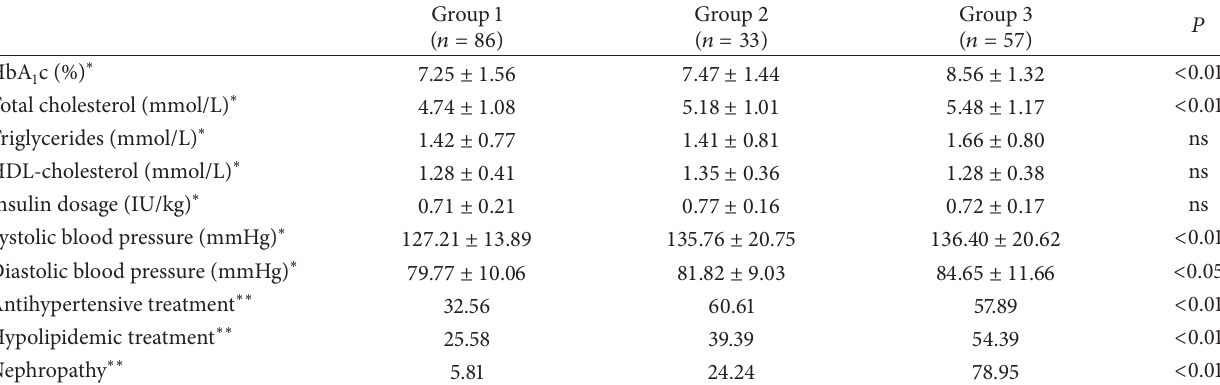
Table 2: Metabolic and clinical parameters of type 1 diabetic patients ( 𝑛 = 176 ) divided into three groups according to diabetic retinopathy status.